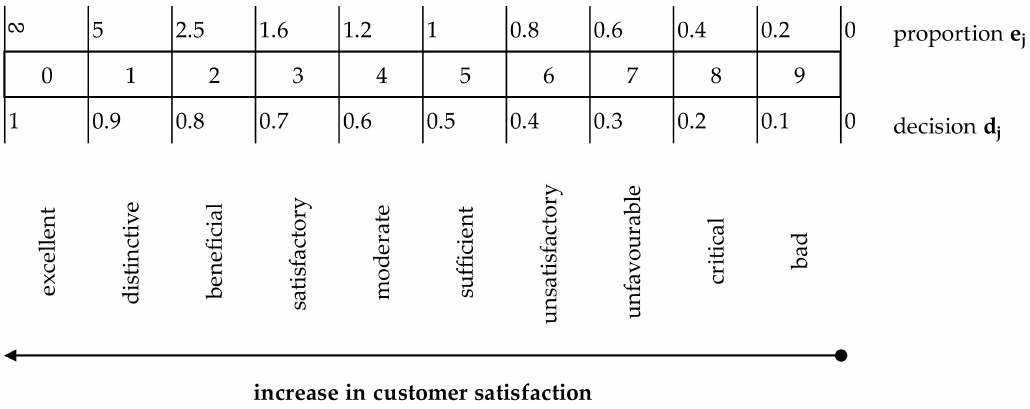
Figure 8. Relative scale of states of customer satisfaction. Own study based on